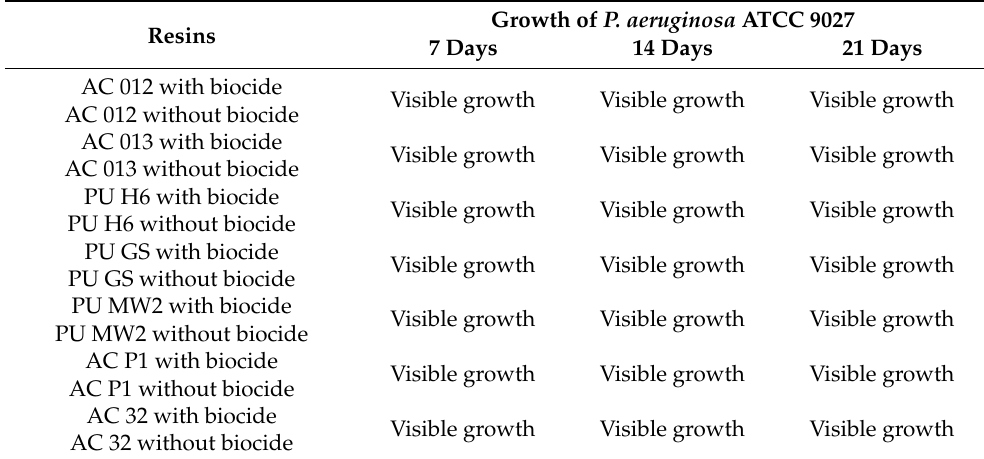
Table 1. Growth of P. aeruginosa ATCC 9027 in the subcultures on cetrimide agar from the different resins treated and not treated with the biocide (OIT, 15%) 7, 14 and 21 days after